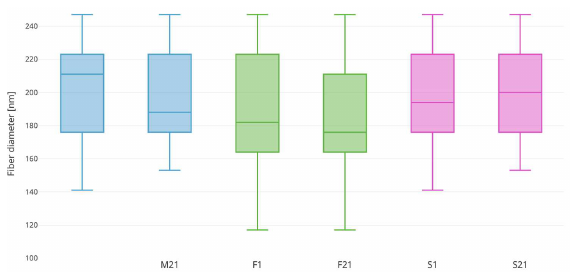
Figure 9. A box plot comparing the fiber diameter after first (M1) and 21 (M21) in medium, 1. (F1) and 21. (F21) days of fibroblast culture and 1. (S1) and 21. (F21) days of culture of fibroblasts and 1. (S1) and 21. (S21) days of cultivation with osteoblasts. Fiber diameters are not statistically significant